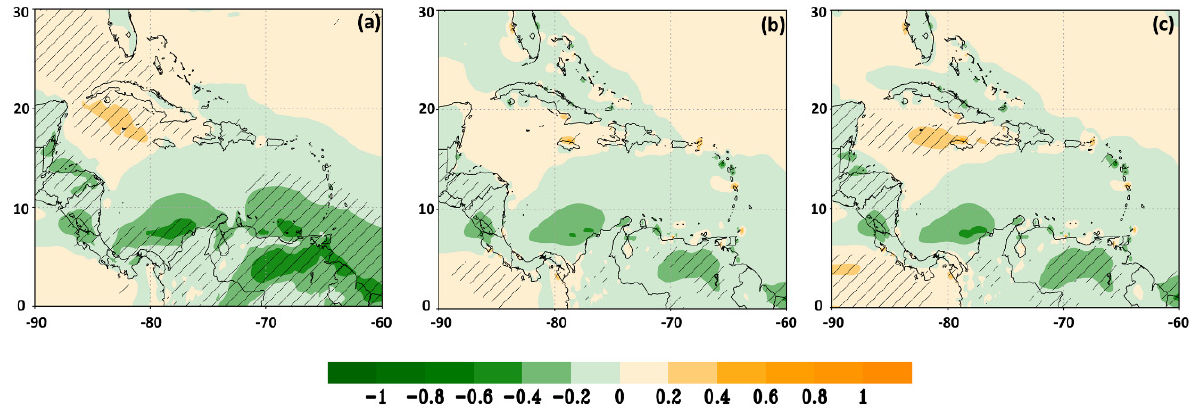
Figure 10. Diagram showing the differences between the warming target thresholds for 10 m wind speed. ( a ) The difference between baseline and wind speeds at 1.5 °C. ( b ) The difference between 1.5 and 2.0 °C and ( c ) between 1.5 and 2.5 °C.